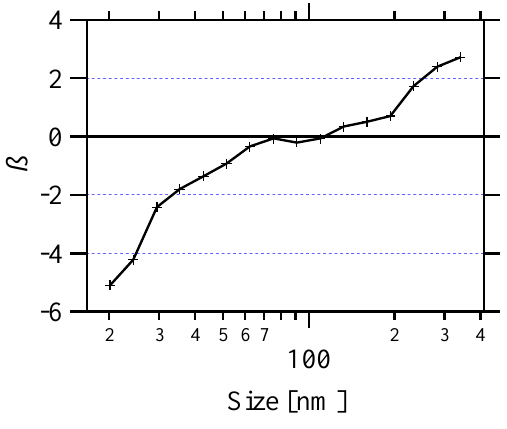
Fig. 8. The distribution of β (Eq. 6) with size, D , determined using the median size distribution shown in Fig.